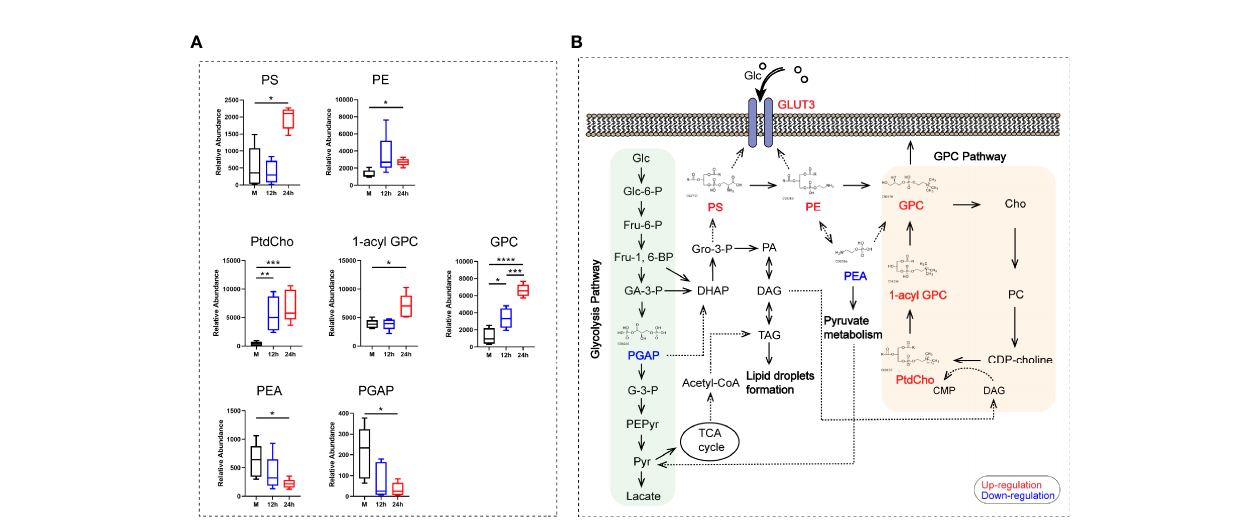
FIGURE 6 | The analysis of the glycerophospholipid metabolism pathway-related metabolites. (A) Relative abundance of seven differential metabolites contributing to the GPC pathway of glycerophospholipid metabolism. (B) Schematic pathway map of the metabolites in the main metabolic pathways in monocytes stimulated with C. albicans . Glc, glucose; Glc-6-P, glucose-6-phosphate; Fru-6-P, fructose-6-phosphate; Fru-1,6-BP, fructose-1,6-bisphosphate; GA-3-P, Glyceraldehyde-3- phosphate; PGAP, glyceric acid 1, 3-biphosphate; G-3-P, 3-phosphoglycerate; PEPyr, phosphoenol- pyruvate; Pyr, pyruvate; DHAP, dihydroxyacetone phosphate; Gro-3-P, glycerol-3- phosphate; PA, phosphatidate; DAG, diacylglycerol; TAG, triacylglyceride; TCA, tricarboxylic acid cycle; PS, phosphatidylserine; PE, phosphatidylethanolamine; PEA, O-phospho-ethanolamine; GPC, glycerophosphocholine; Cho, choline; PC, phosphorcholine; CDP-choline, cytidine diphosphate choline; CMP, cytidine monophosphate; PtdCho, phosphatidylcholine; 1-acyl-GPC, 1-acyl-sn-glycero-3- phosphocholine; For all tests, signi fi cance values are denoted as follows: **** P < 0.0001; *** P < 0.001; ** P < 0.01; * P <